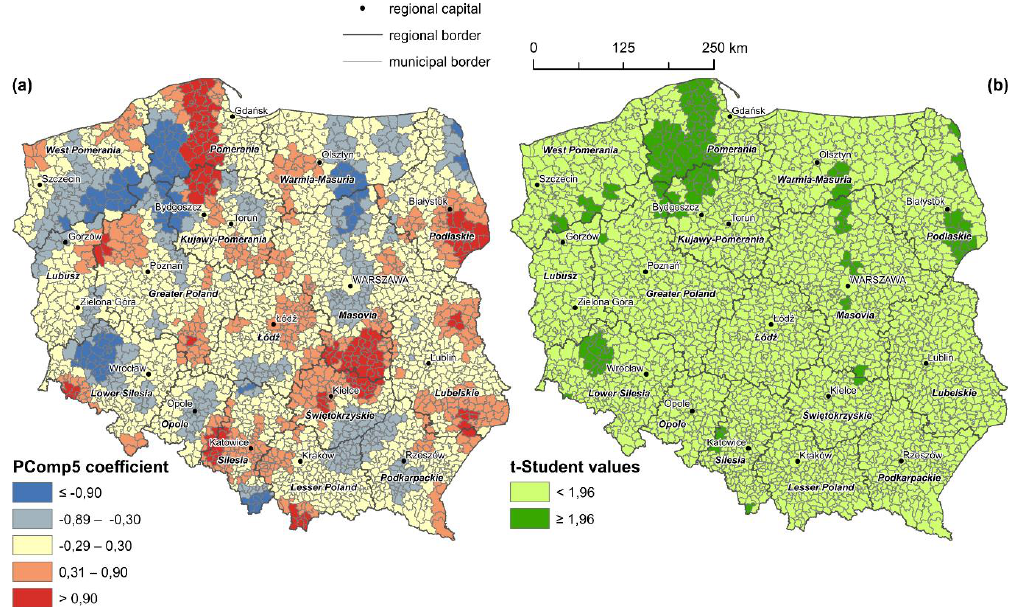
Figure 9. Value ( a ) and significance ( b ) of impact of the fifth component “depopulation” on land cover changes in Poland, in the years 2012–2018.